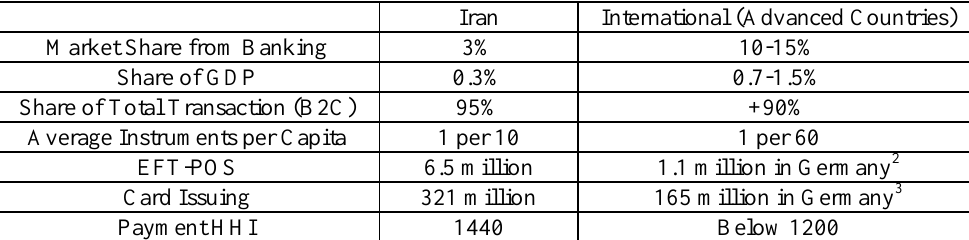
Table 1. Payment Industry